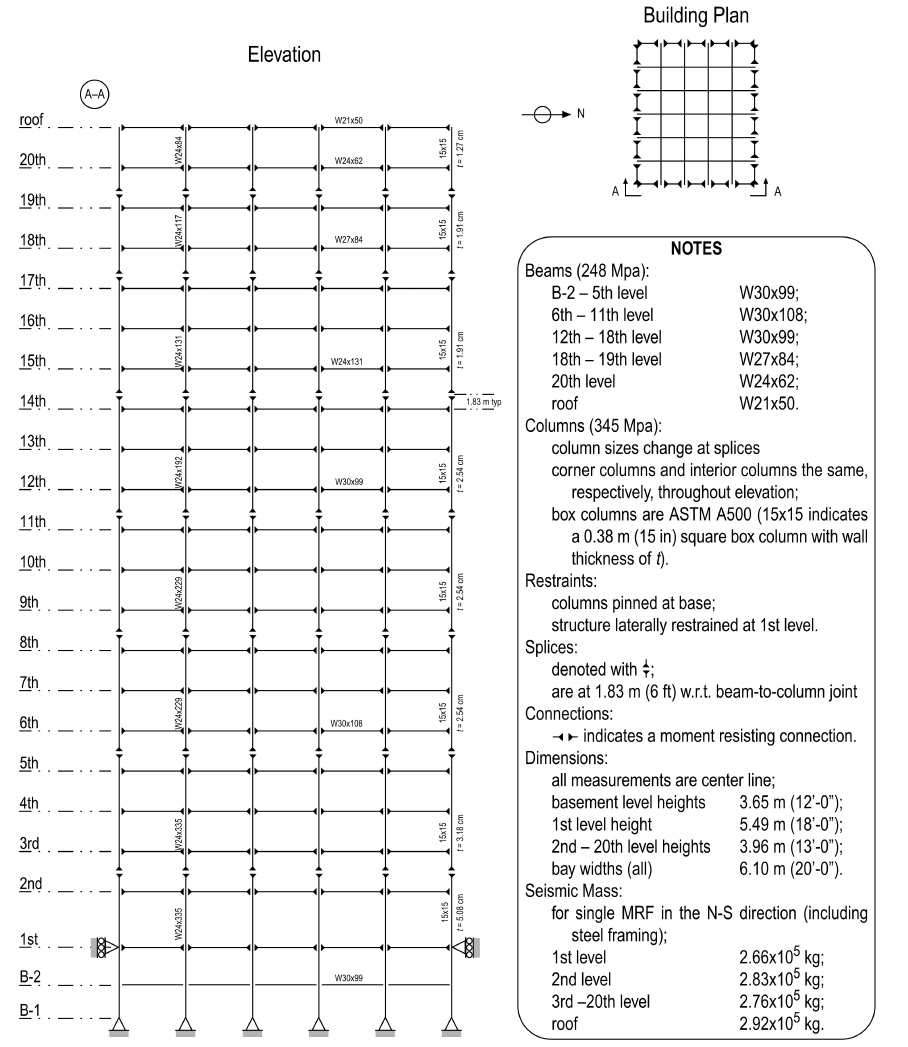
Figure 13. Cross-section frame in the north–south direction [46].